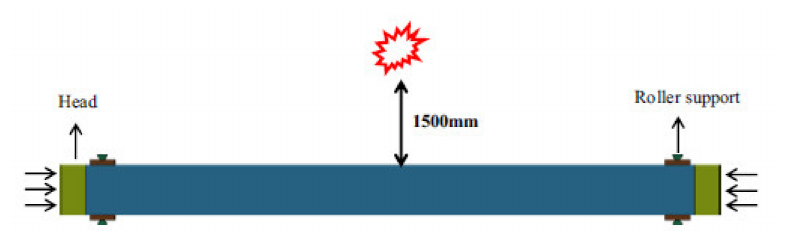
Figure 18. The numerical model of the blast test [12]. Copyright permission obtained from